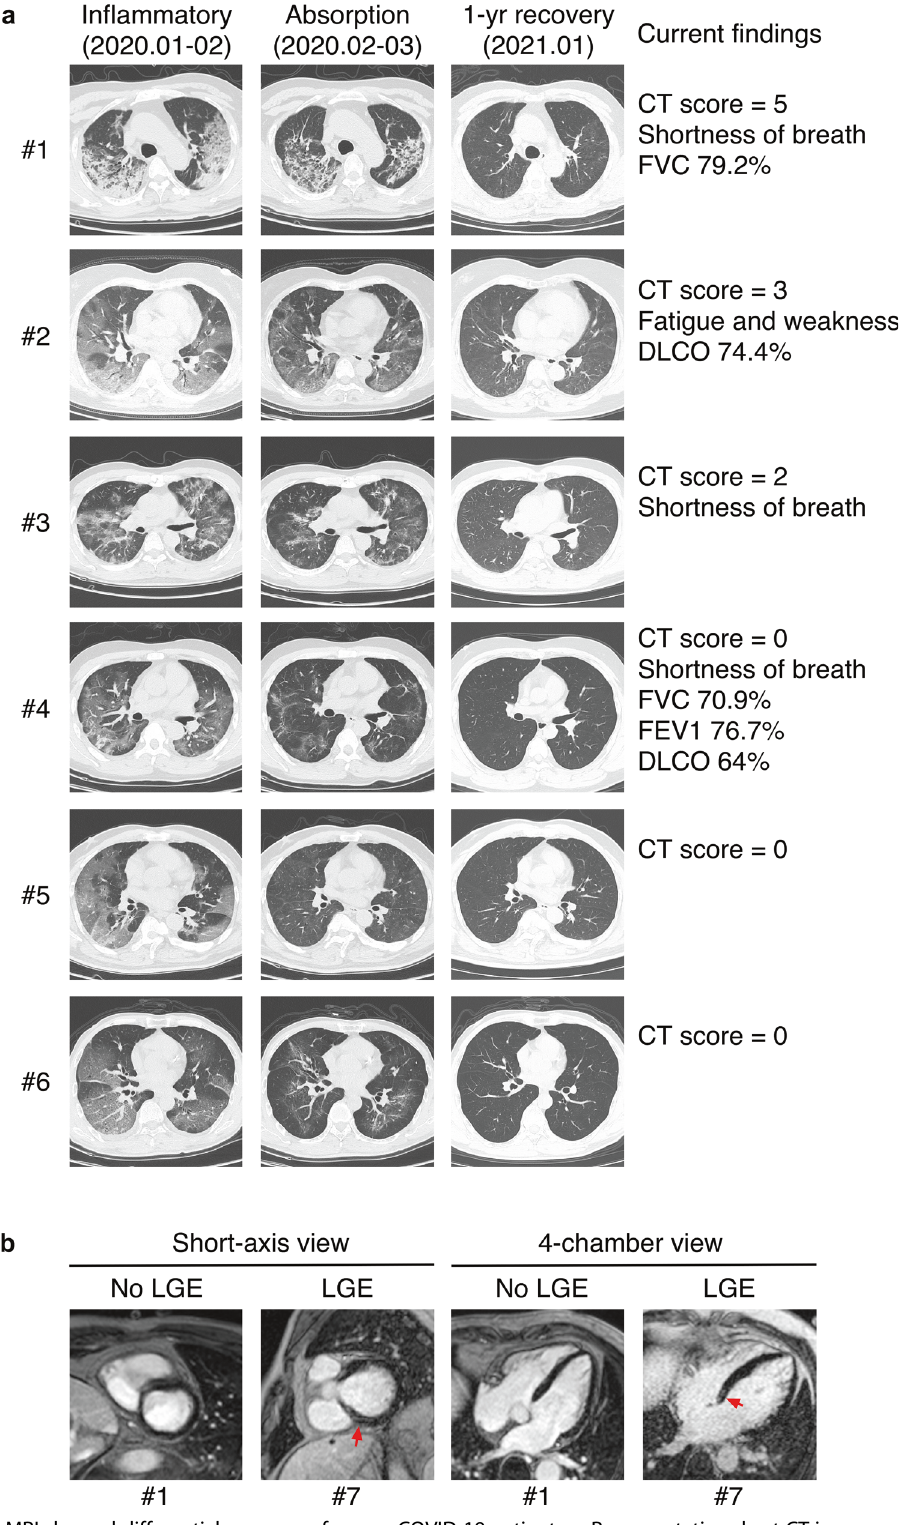
Fig. 4 Chest CT and cMRI showed differential recovery of severe COVID-19 patients. a Representative chest CT images and related fi ndings of participants who have recovered from severe COVID-19. Images in the left column show wide-spreading lung in fl ammation during the acute phase. Images in the middle column show partial absorption of lung lesions during early recovery. Images in the right column show structural recovery of the lung 10 – 12 months after infection. CT score of the right column images, symptomatic, and PFT fi ndings were also listed on the right. b Representative cMRI images of focal myocardial fi brosis and images without fi ndings. PSIR sequences in short-axis view and 4-chamber view showed focal LGE in the left ventricular midwall (red